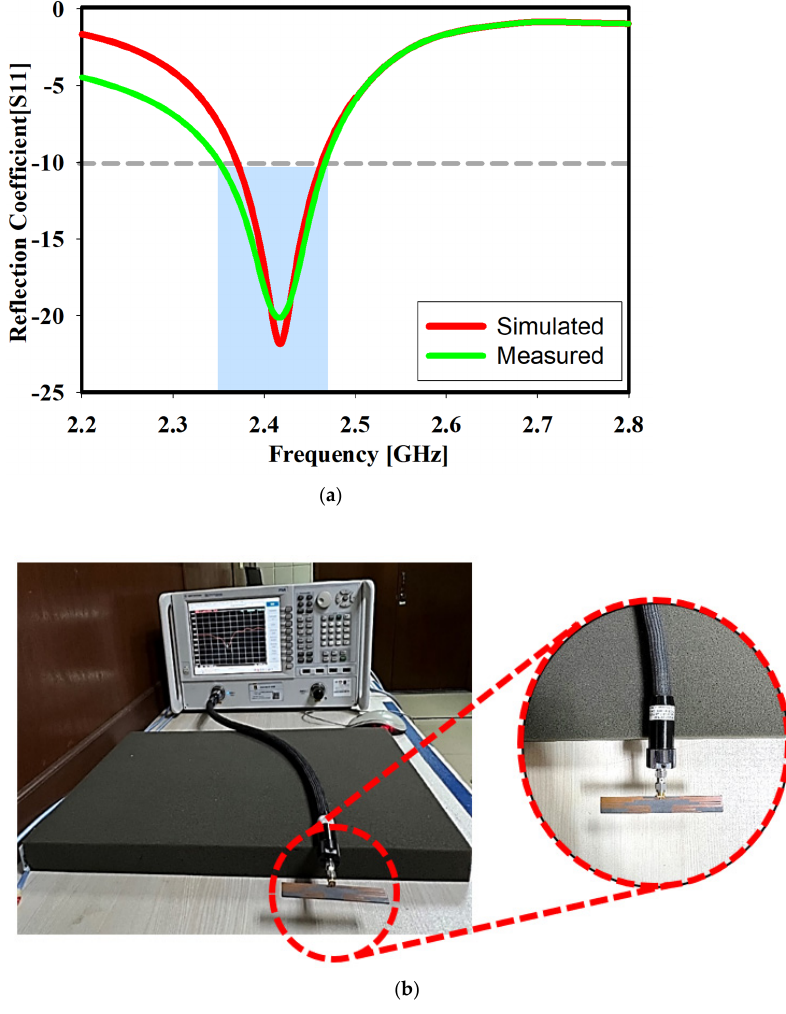
Figure 8. ( a ) The simulated and measured reflection coefficient of the suggested printed ML monopole antenna and ( b ) the reflection coefficient measurement setup. Figure 9 illustrates the simulated and measured gain of the meander monopole an ‐ tenna is 2.88 dB at 2.45 GHz. Furthermore, an agreement between the measured and sim ‐ ulated gains has been accomplished. Due to the meander line, the antenna gain with the meander line increased and was enhanced. Simulated and measured antenna efficiencies are shown in Figure 10. The proposed antenna has a maximum radiation efficiency of 99.4% at 2.4 GHz and a maximum total efficiency of 92% at 2.45 GHz.